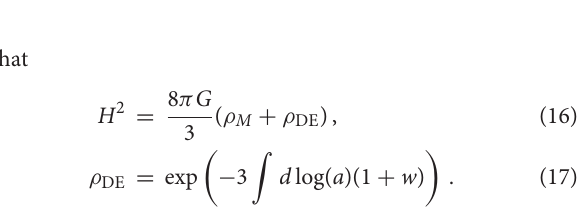
FIGURE 4 | Effective descriptions of cosmological gravity, their relations and main advantages/shortcomings. Theories of gravity based on a gravitational Lagrangian are described in section 2.1. The effective theory approach is described in section 2.2.1 and the Gravitational “constants” in section